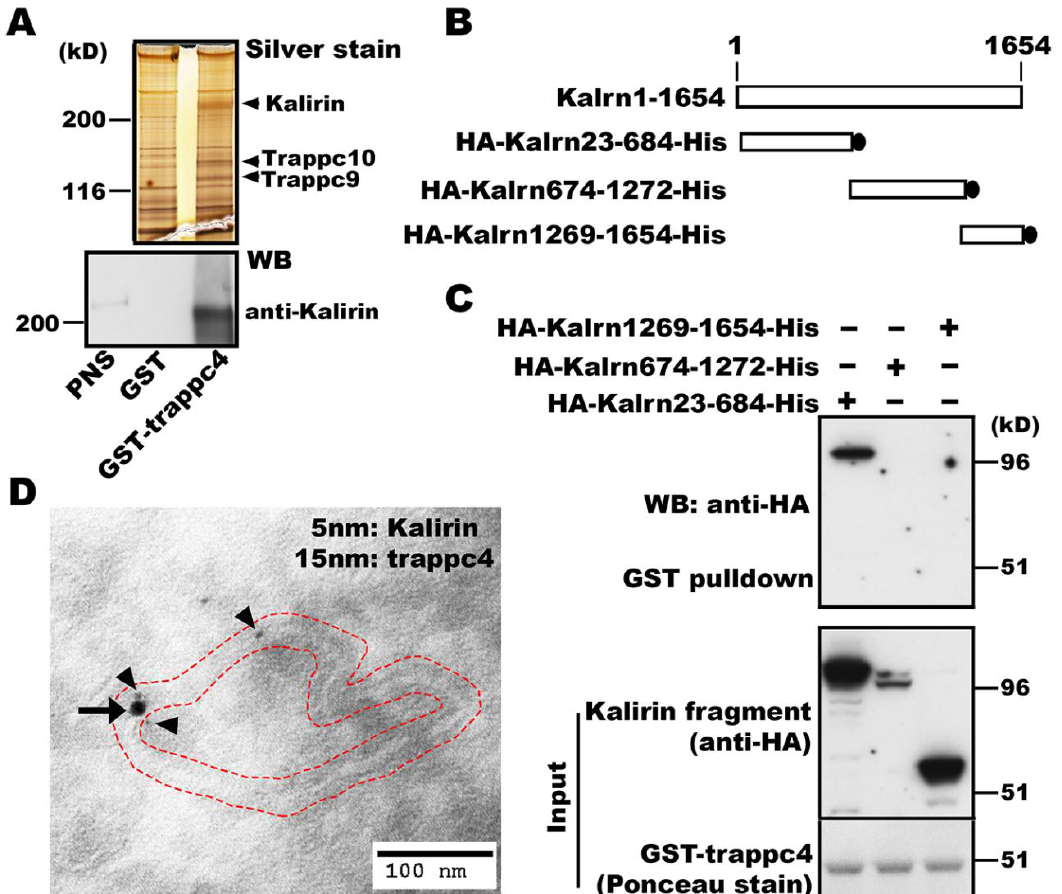
Figure 1. Kalirin is associated with trappc4. ( A ) Mass spectrometry analysis of proteins associated with GST-trappc4. Solubilized cellular membranes from 293T cells transfected with pcDNA 3 expressing GST-trappc4 or GST alone were incubated with glutathione resins. Proteins on resins were analyzed by SDS-PAGE followed by silver staining (upper panel) or Western blot (lower panel). Upper panel: Arrows indicate proteins identified from gel slices precipitated by GST-trappc4 but not by GST alone. Lower panel: Western blot analysis with antibodies specific for kalirin verifies the association of kalirin with GST-trappc4 but not with GST alone. ( B ) Schematic representation of constructs expressing di ff erent domains of kalirin. The amino acid sequence for generating the constructs was based on rat kalirin-7 [26]. The number of amino acids is shown above. ( C ) Association of the N-terminal portion (Kalrn23-684) of kalirin with trappc4. Post-nuclear supernatants of 293T cells transfected with plasmids expressing the indicated regions of kalirin were incubated with GST-trappc4 pre-immobilized on glutathione resins. After washes, proteins on resins were analyzed by Western blot with indicated antibodies. Shown are data from one of three experiments with similar results. ( D ) Co-localization of trappc4 with kalirin at tubulovesicular membranes. Double immunogold labeling of ultrathin sections of NRK cells was performed as in Methods. Arrowheads point to labeling of endogenous kalirin (5 nm gold particles), whereas the arrow indicates labeling of endogenous trappc4 (15 nm gold particle) in proximity to kalirin labeling at a tubulovesicular membrane structure, the membranes of which lie in between the two dashed red tracing